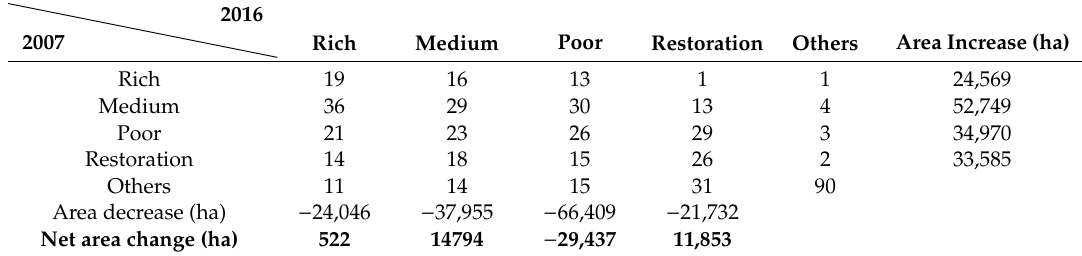
Table 6. Conversion matrix of forest types between 2007 and 2016 in percentage (%) and area